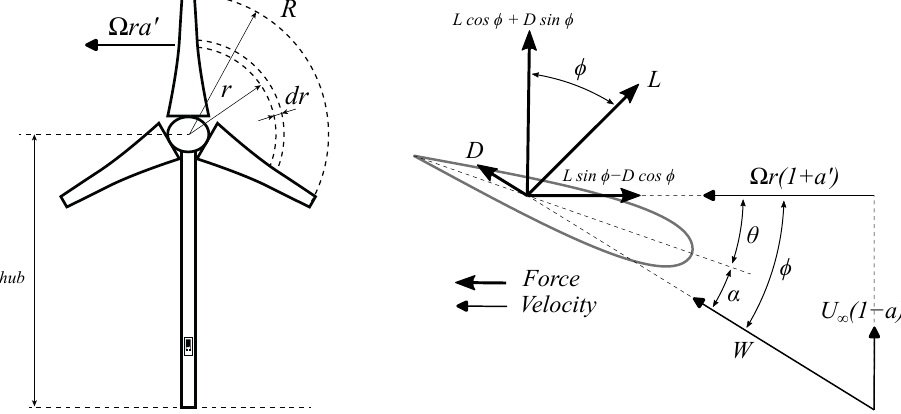
Figure 1. Main parameters of the wind turbine ( left ) and rotor plane forces and velocities ( right